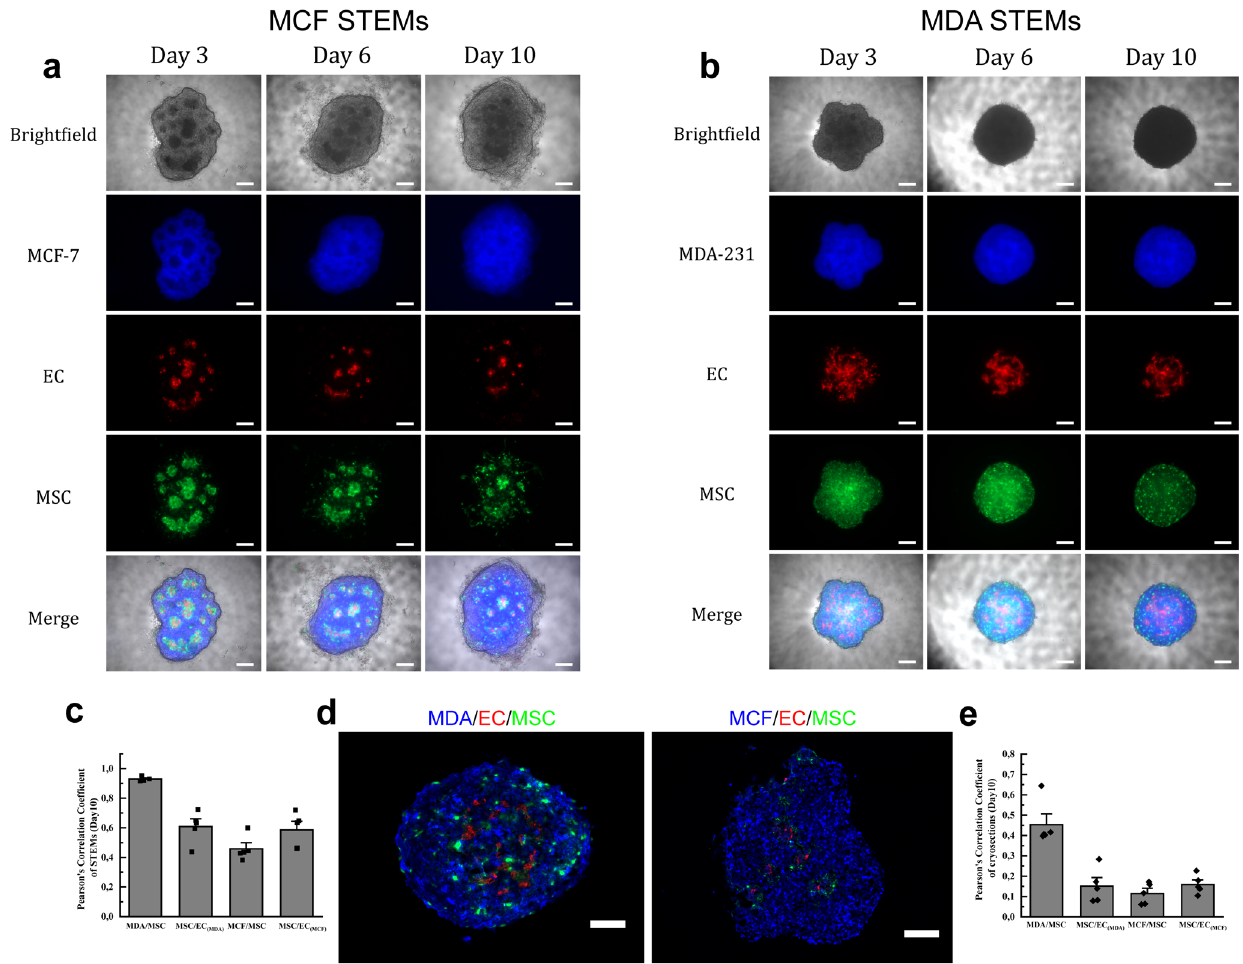
Fig. 1 Organization of BCC in STEMs is determined by MSC-EC interactions. a Bright fi eld and fl uorescence microscopy images (MCF-7/BFP, EC/ tdTomato, and MSC/GFP) of MCF STEMs, scale bar: 200 µ m. b Bright fi eld and fl uorescence microscopy images (MDA-231/BFP, EC/tdTomato, and MSC/ GFP) of MDA STEMs, scale bar: 200 µ m. c Pearson correlation coef fi cients (PCCs) of MDA/MSC, MSC/EC (MDA), MCF/MSC, MSC/EC (MCF) of STEMs after 10 days, n = 5. d Fluorescence images of cryosections of MDA and MCF STEMs on day 10 showing the distinct differences in the distribution of MSC and the organization of EC in the two systems. Note the close association between MSC and BC in MDA STEMs, which is lacking in the MCF STEMs, scale bar of the left image: 100 µ m, scale bar of the right image: 200 µ m. e PCCs of MDA/MSC, MSC/EC (MDA), MCF/MSC, MSC/EC (MCF) of cryosections after 10 days, n =